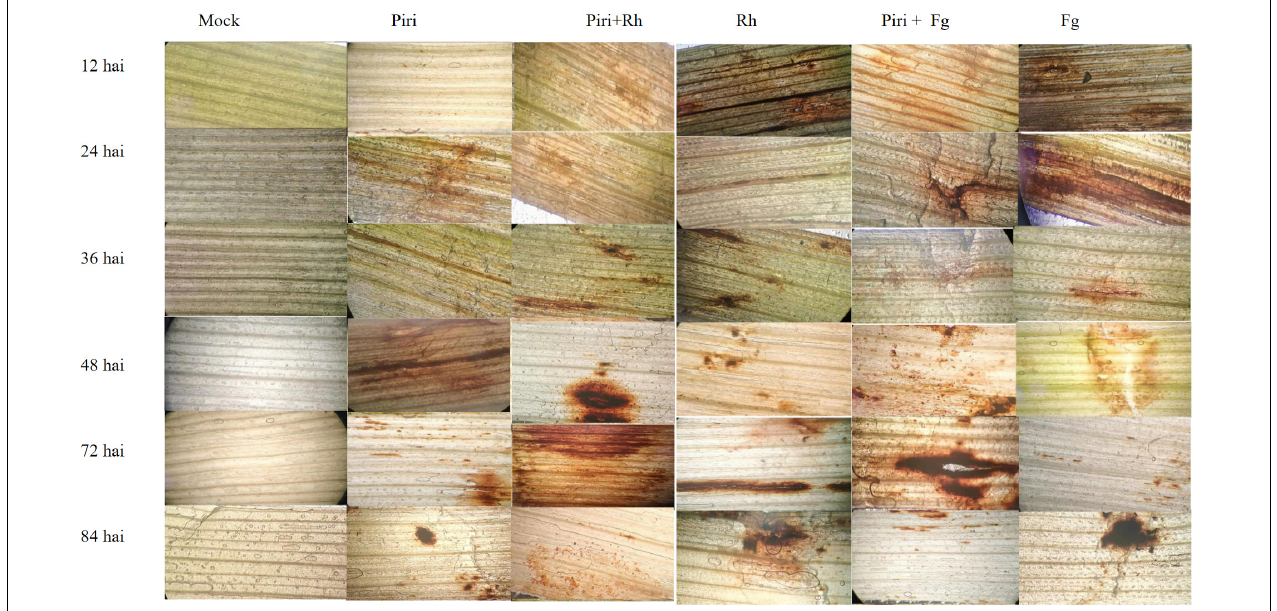
FIGURE 5 | Detection of H 2 O 2 in wheat leaf segments using 3, 3- diaminobenzidine (DAB) at various hours post inoculation under different treatments. Piri, P. indica ; Fg, F. graminearum ; Rh, R. cerealis ; Piri + Fg, P. indica + F. graminearum ; Piri + Rh, P. indica + R. cerealis.